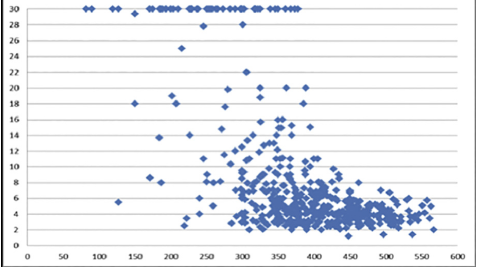
Fig 1. Individual details of TRF scores (in seconds) and 6MWT results (in